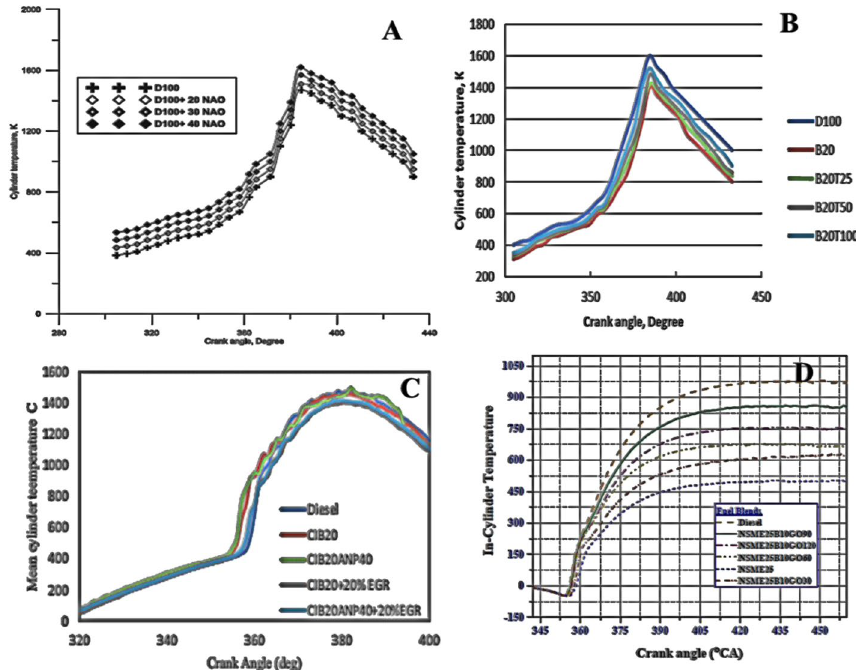
Fig. 12 Effect of cylinder temperature of nano-added diesel or